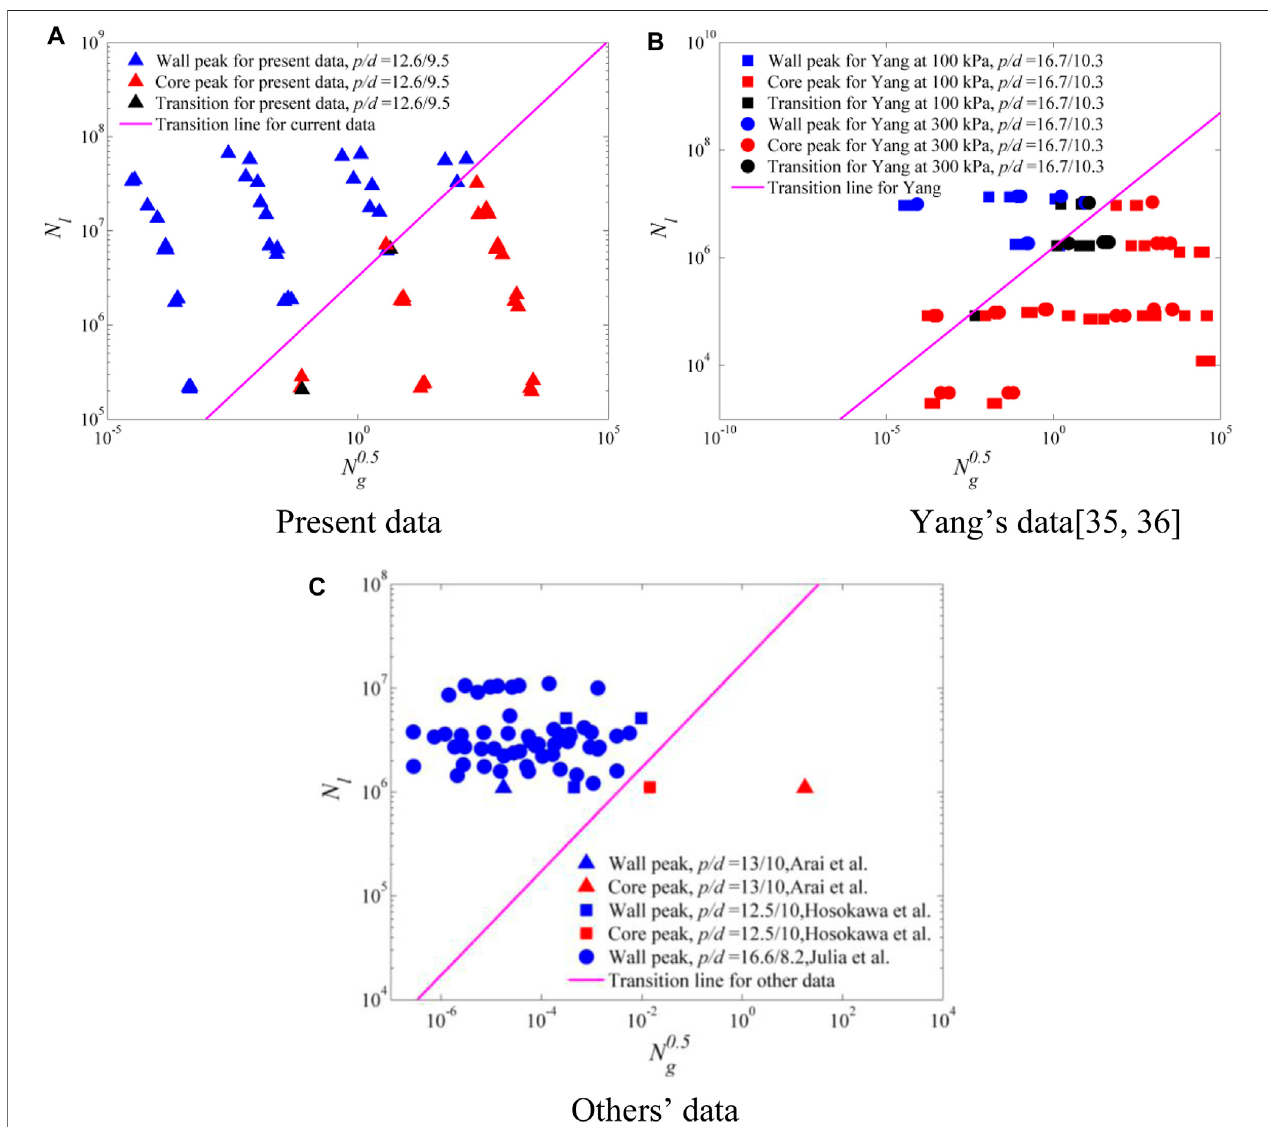
FIGURE 14 | Transition lines for different data. (A) Present data. (B) Yang ’ s data (Yang, 2011; Yang, 2015). (C) Others ’ data.